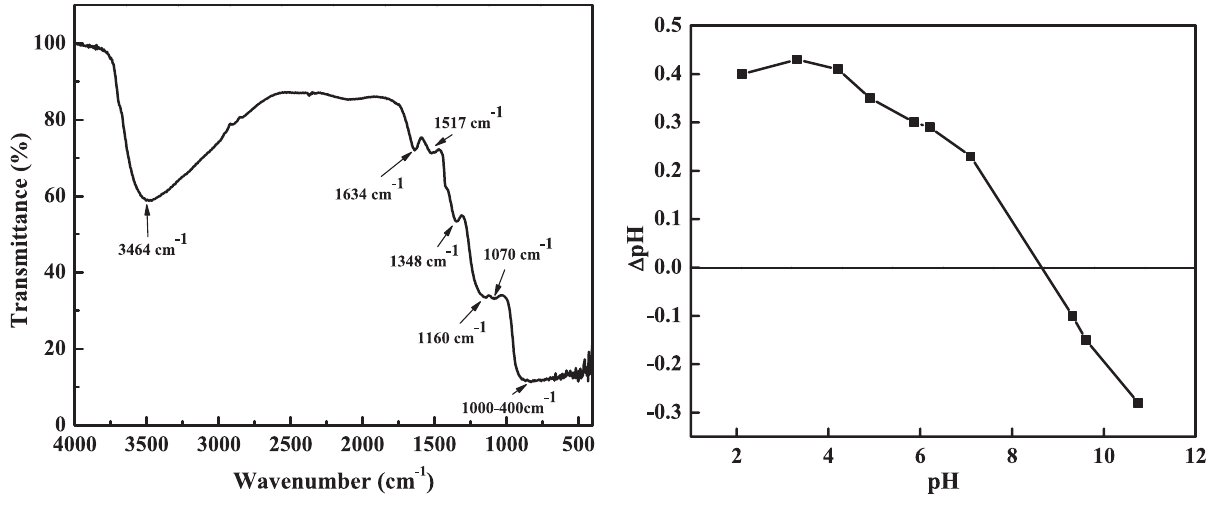
Fig. 9: FT-IR spectrum of the calcined particles shown in Fig. 1B Fig. 10: Point of Zero Charge (PZC) of the particles shown in Fig.